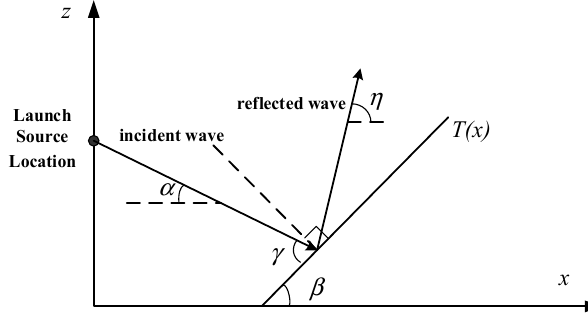
Figure 5. Piecewise linear transformation of terrain. For piecewise linear terrain, assuming the angle β between the terrain and the horizontal plane.